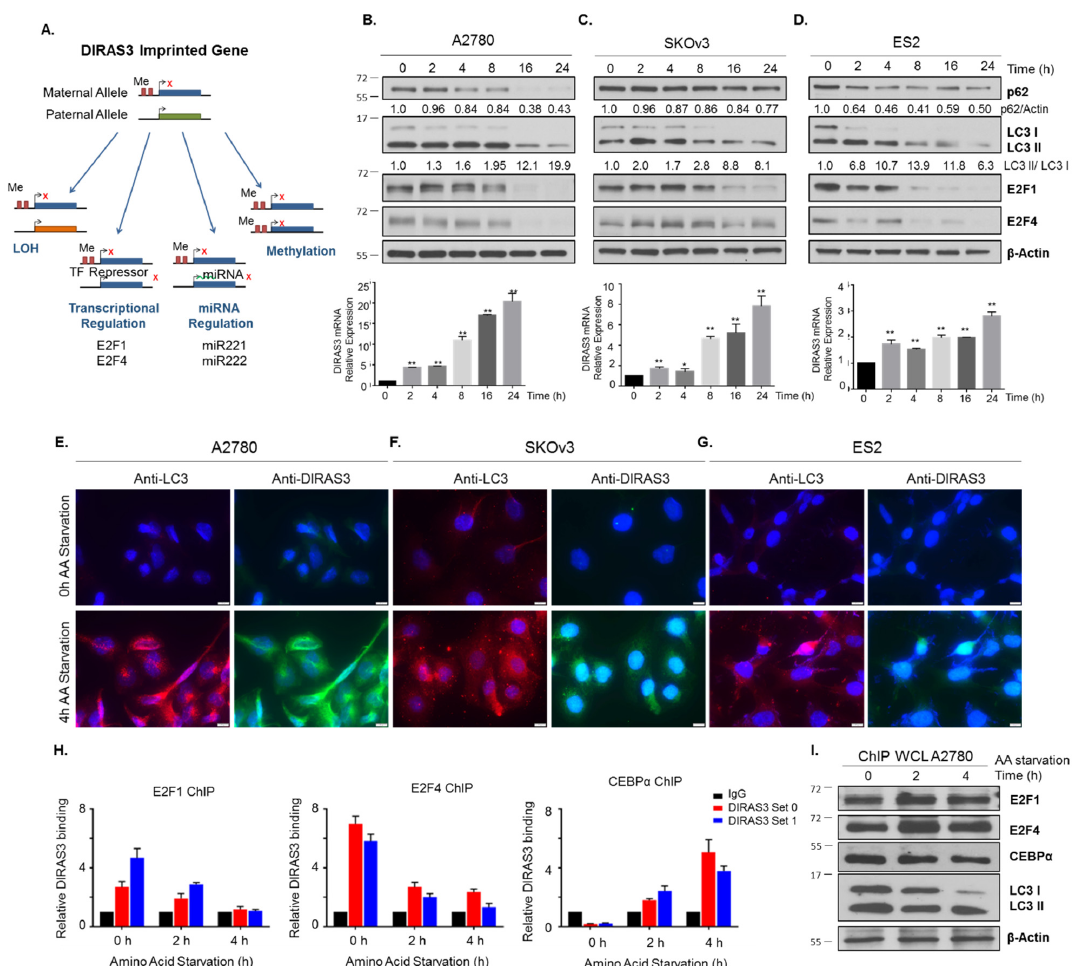
Figure 4 . Amino acid deprivation induces DIRAS3 expression which correlates with an increase in autophagy. ( A ) DIRAS3 is a maternally imprinted tumor suppressor gene that is downregulated in ovarian cancer by several mechanisms including: LOH, transcriptional and miRNA regulation, and methylation of the non-imprinted allele. ( B ) A2780 ( C ) SKOV3 and ( D ) ES2 ovarian cancer cells were treated with amino acid free RPMI media from 0 h to 24 h. Protein lysate and RNA were collected for analysis. Western blots were performed to examine the expression of E2F1 and E2F4 transcription factors and autophagy markers p62 and LC3B. qRT-PCR was performed to determine the relative mRNA expression of DIRAS3 following amino acid deprivation. Immunofluorescence staining of ( E ) A2780 ( F ) SKOV3 and (G) ES2 cell